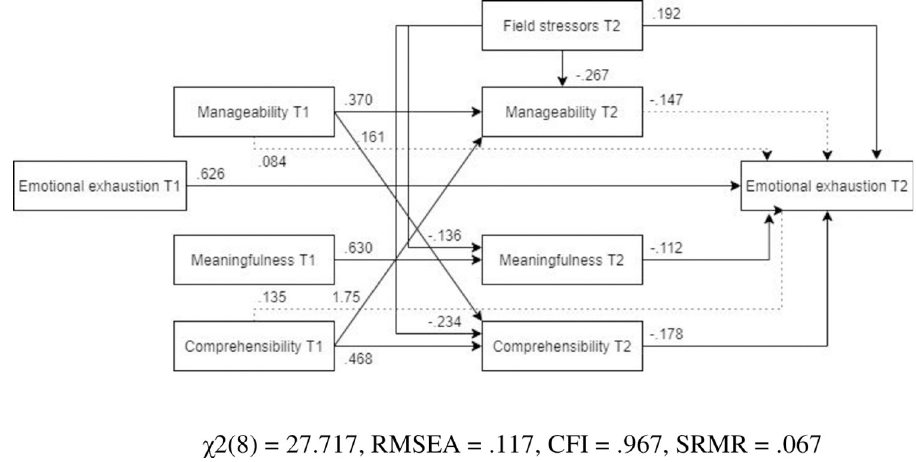
Fig 12. Tested structural equation model for emotional exhaustion—males. χ 2(8) = 27.717, RMSEA = .117, CFI = .967, SRMR = .067.